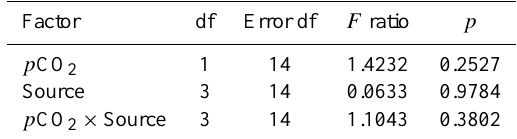
Table 6. Two-way ANOVA: metamorph Mg/Ca.